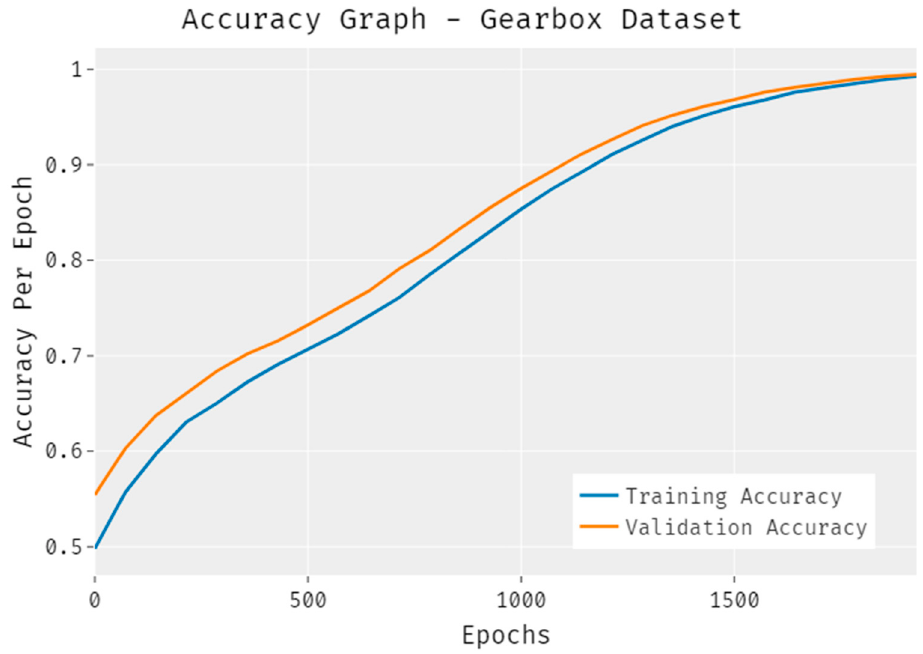
Figure 4. Accuracy analysis graph of the SPOAI-FD methodology under Gearbox dataset